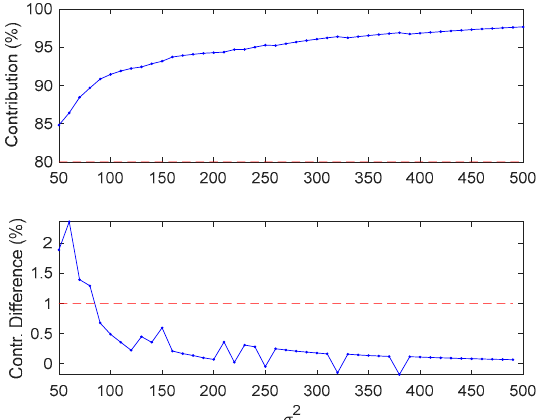
Figure 6. Contribution of above-average eigenvalues for each Gaussian width (top) and the change of contribution between the adjacent sum of chosen eigenvalues (bottom).